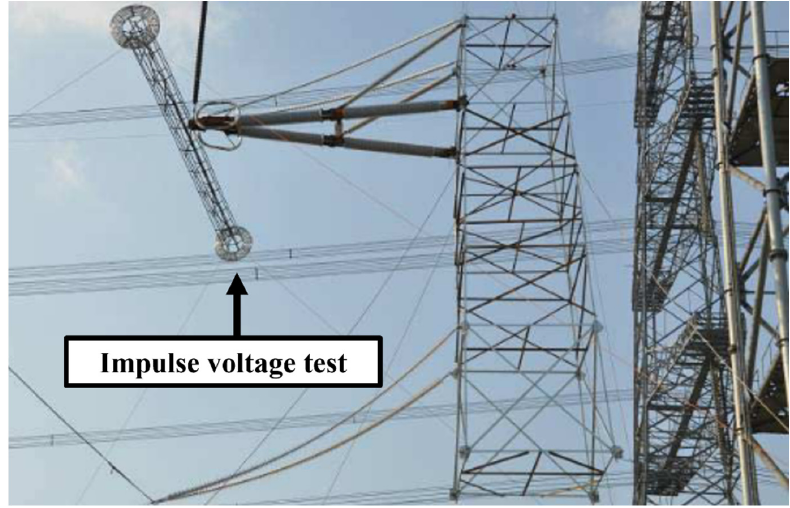
Figure 16. Impulse voltage test for electric field computation [38].